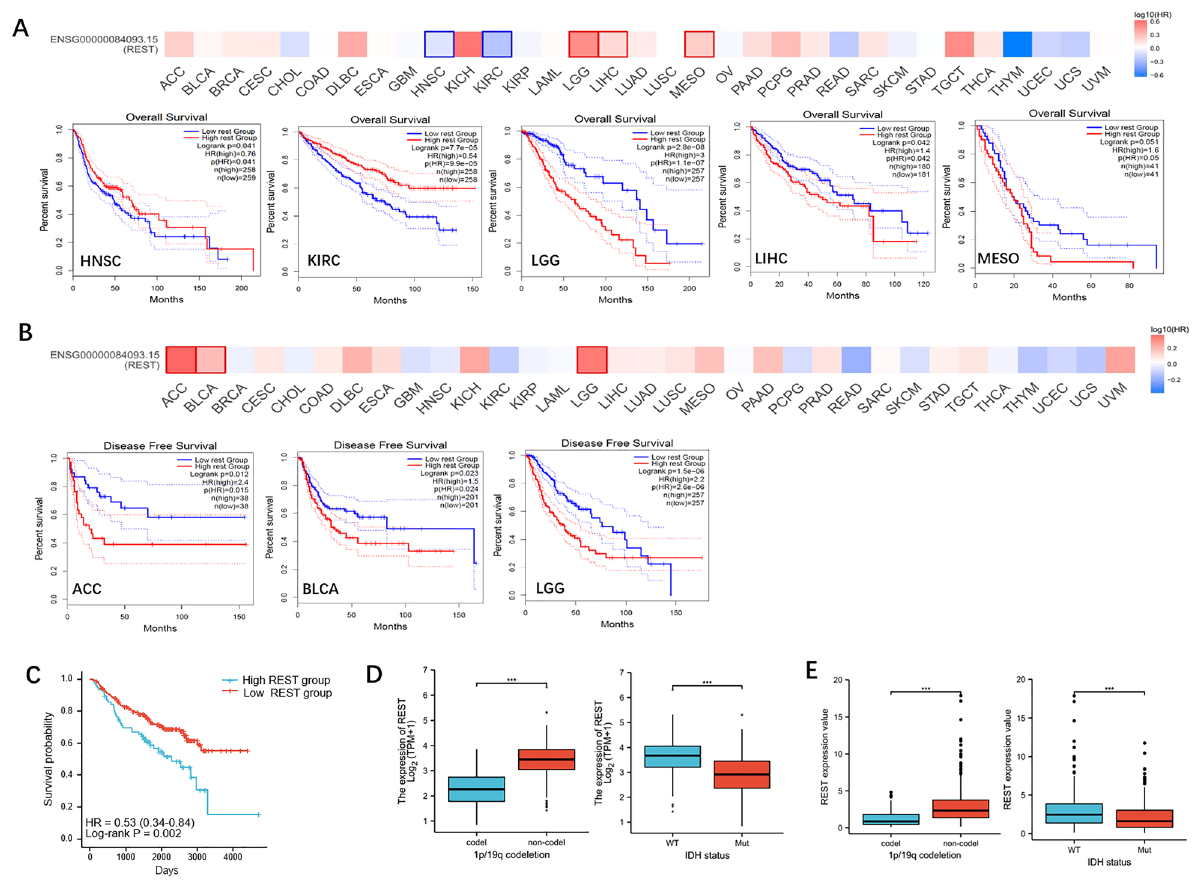
Figure 2. The overall survival (OS) and disease-free survival (RFS) analysis for REST in human cancers. ( A ) The overall survival map and Kaplan–Meier curves with positive results of different tumors in TCGA cohort with different REST gene expression by GEPIA2 (http:// gepia. cancer- pku. cn/). ( B ) The disease-free survival map and Kaplan–Meier curves with positive results of different tumors in TCGA cohort with different REST gene expression by GEPIA2 (http:// gepia. cancer- pku. cn/). ( C ) The Kaplan–Meier curves of glioma in CGGA cohort with different REST gene expression by GraphPad Prism 9.3.1 (https:// www. graph pad. com/). log-rank in non-1p/19q codeletion or IDH status-WT gliomas in CGGA cohort by GraphPad Prism 9.3.1 (https:// www. graph pad. com/). *** P value <